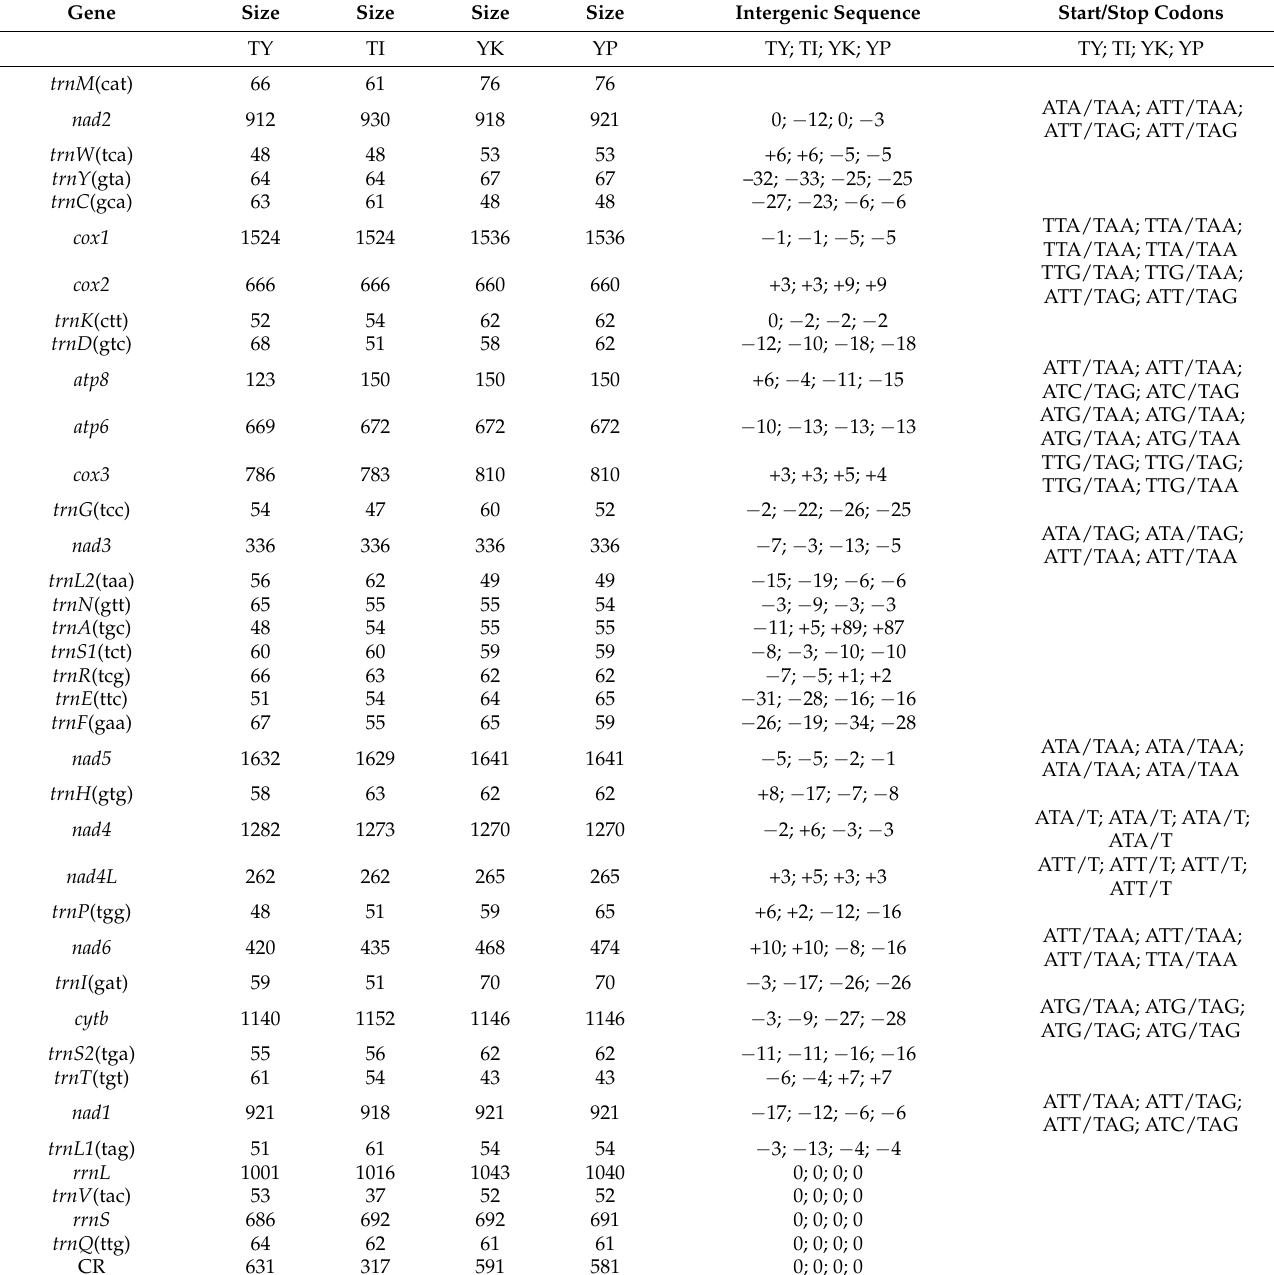
Table 3. Gene order and features of mitochondrial genome of four Mysmenidae